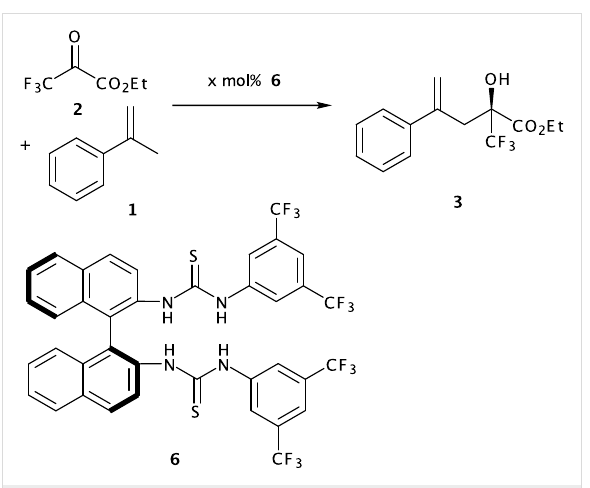
Scheme 3: Asymmetric carbonyl ene reaction mediated by chiral